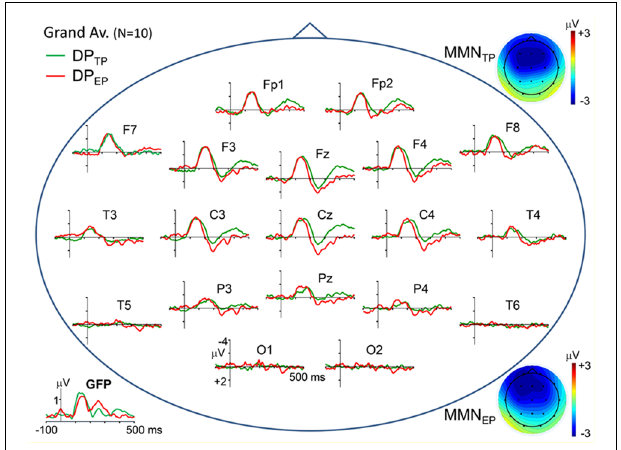
FIGURE 2 | Scalp topographical plots of the grand average DPs to timely and earlier pitch deviances (DP TP and DP EP , respectively). Potentials are re-referenced to averaged earlobes. Global field power plots of the grand average DPs are at the bottom-left corner. At the top-right and bottom-right corners, scalp potential maps of the MMN components (mean over 120–180 ms latency range) in the two DPs are given.